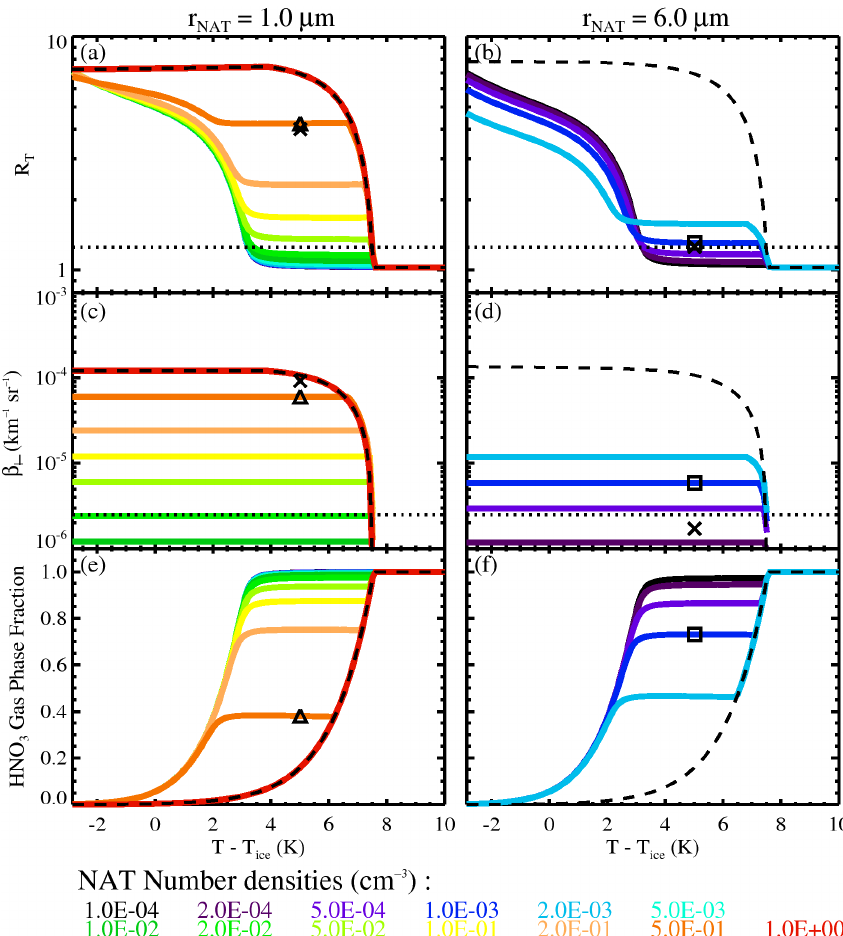
Fig. 4. Temperature variations relative to the frost point of (a, b) total backscatter ratio, (c, d) perpendicular backscatter, and (e, f) total uptake of HNO 3 by STS and NAT particles expressed as the fractional remaining gas-phase HNO 3 , according to the microphysical model of NAT/STS mixtures for different NAT particle number densities in the range 10 − 4 to 1cm − 3 and effective radii of 1-µm and 6-µm. Dotted lines indicate CALIOP detection thresholds of (a, b) R T = 1 . 25 and (c, d) β ⊥ = 2 . 5 × 10 − 6 km − 1 sr − 1 . Dashed lines show the NAT equilibrium curves. Lines are colored according to the corresponding NAT number densities given at the bottom of the figure. Two contrasting scenarios are highlighted, with both causing significant gas-phase HNO 3 depletion: the triangle symbols (a, c, e) denote a small particle/high number density combination and the square symbols (b, d, e) denote large particle/low number density combination. An aspect ratio of 1.2 was used for the T -matrix calculations except for the cross symbols, which used a value of